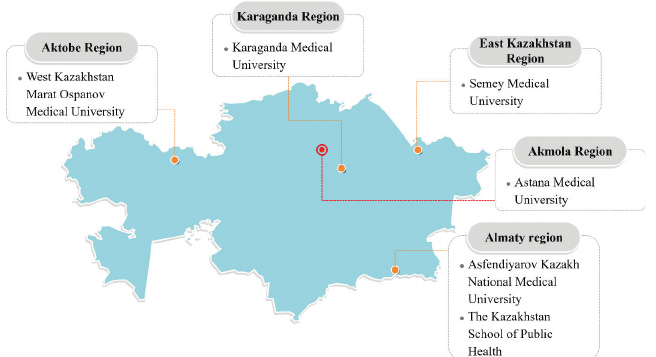
Figure 1 - The geographical spread of medical universities recruited for the